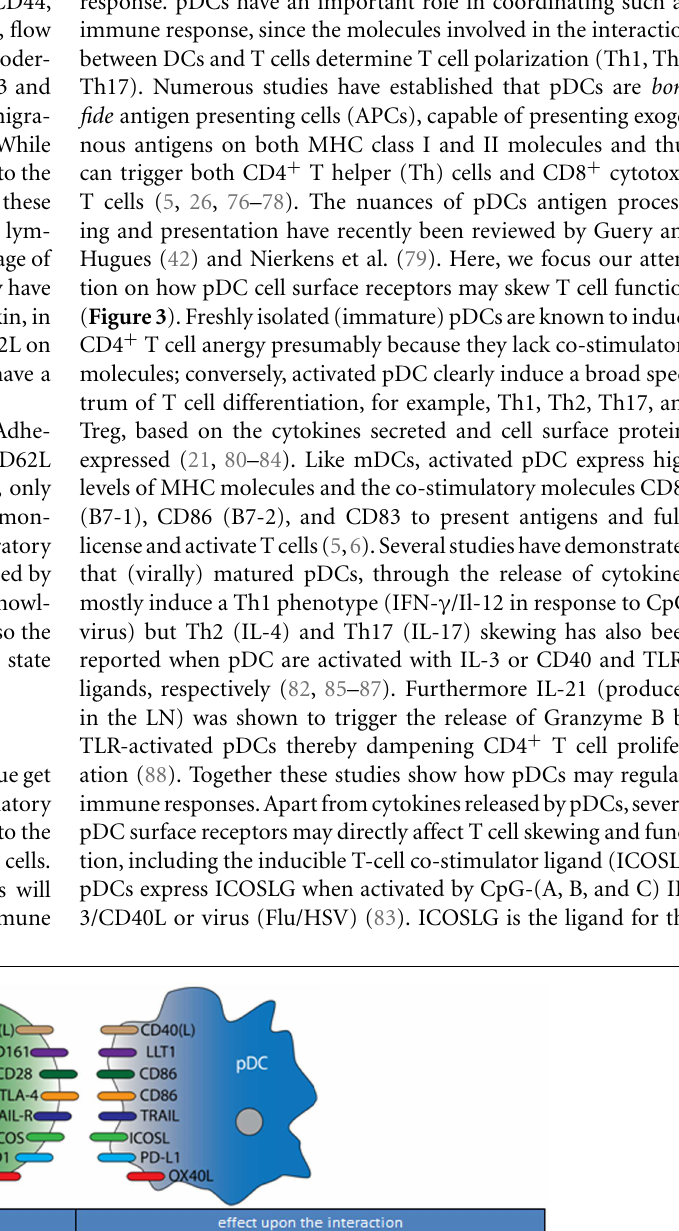
Frontiers in Immunology | Molecular Innate